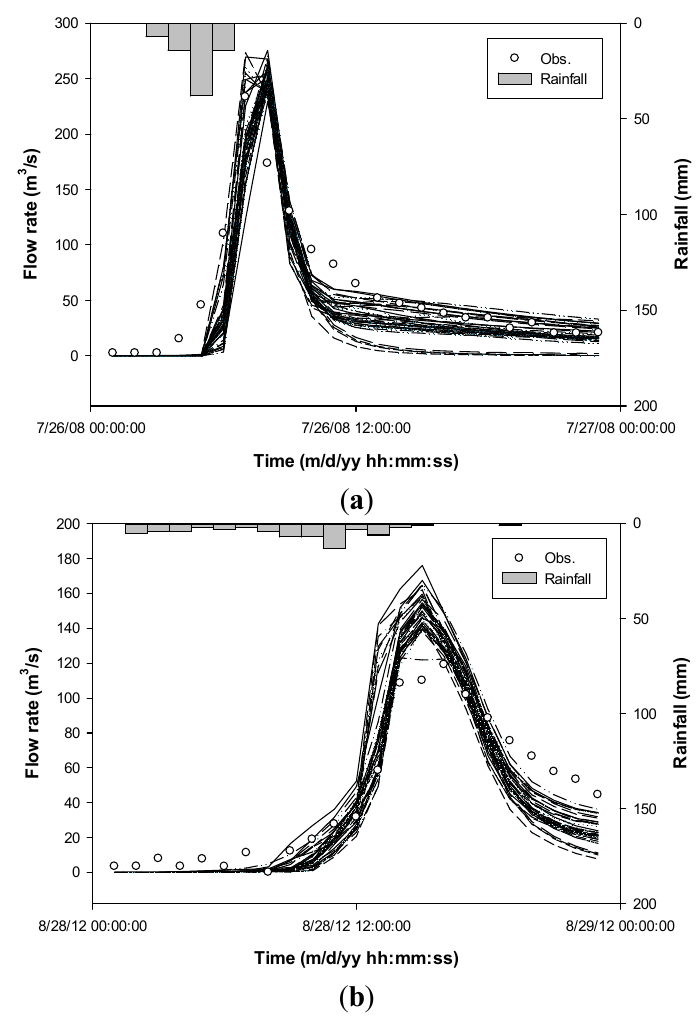
Figure 3. Calibrated hydrographs of E1 and E2 with the 41 optimized parameter sets.